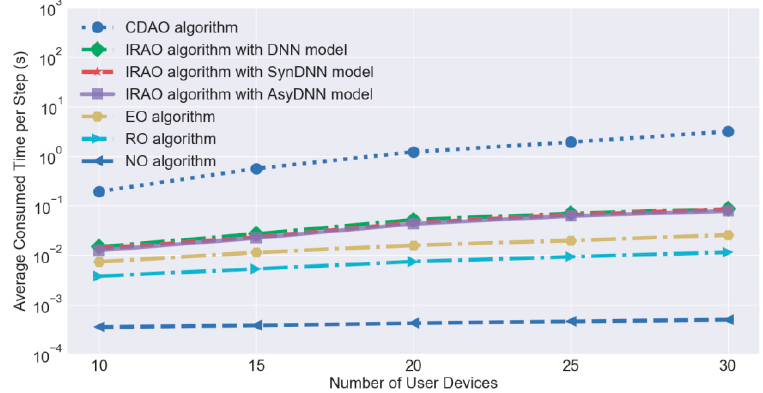
Figure 10. Algorithm efficiency evaluation of IRAO and candidates.